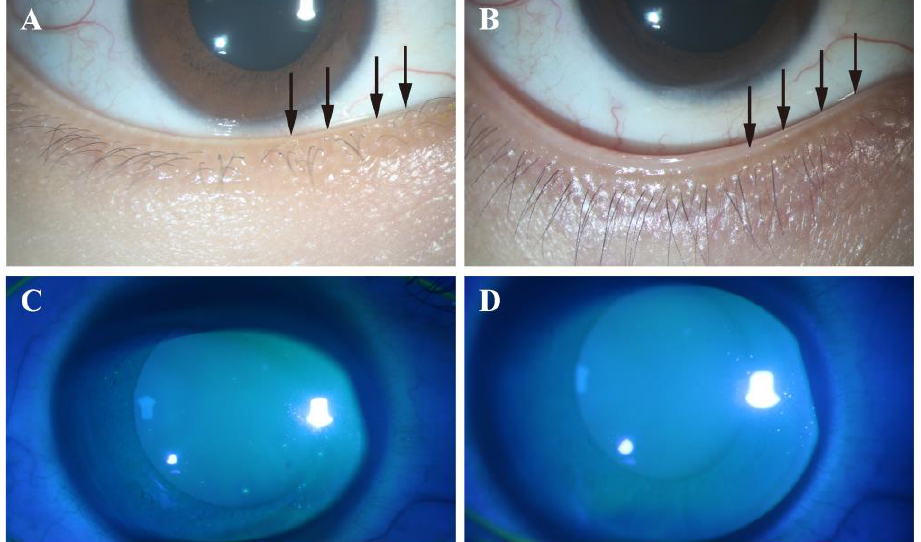
Figure 5. Representative images of lid margin findings and corneal fluorescein staining in the control group. Note that plugging of gland orifices is observed at baseline ( A ), and there were no obvious changes in plugging after 2 weeks ( B ). There was confluent spot staining at baseline ( C ), which was still observed after 2 weeks of treatment ( D ). Arrows indicate plugging.